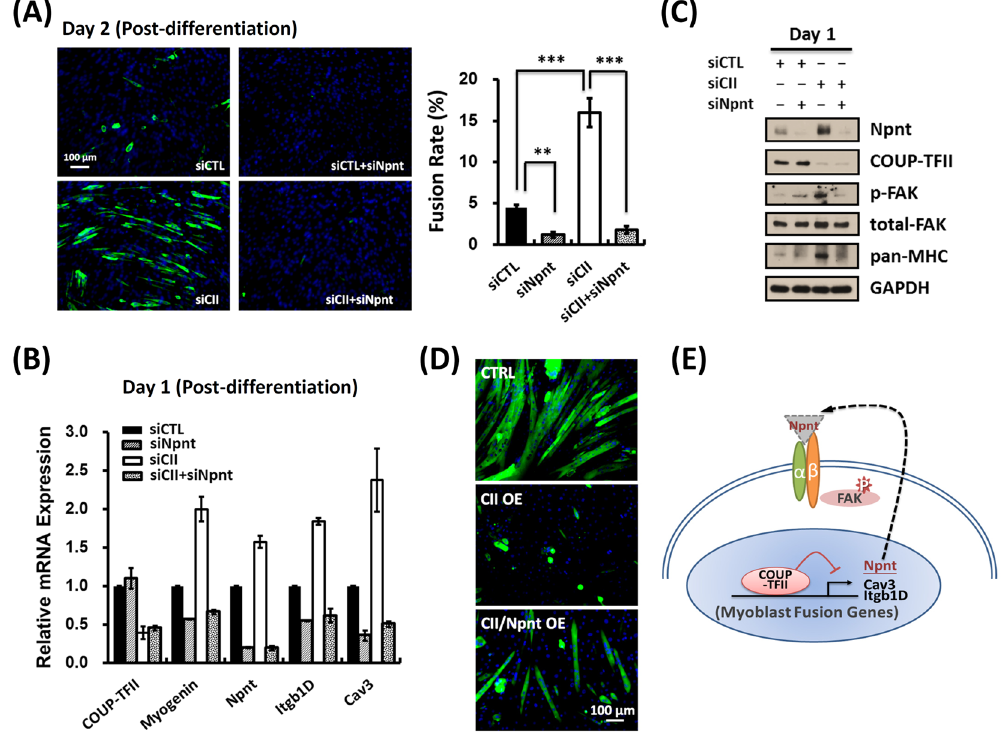
Figure 6. Npnt is essential for COUP-TFII silencing mediated acceleration of myogenesis. ( A ) Two days post- differentiation, indicated cells were fixed and immunostained with pan-MHC (left panel), and their fusion rates were then quantified as the percentage of MyHC + nuclei versus total nuclei (right panel). ( B ) Quantitative RT- PCR examination of indicated genes expression; ( C ) Immunoblotting of indicated protein expression in control, COUP-TFII silencing, Npnt silencing and double silencing C2C12 cells, one day post-differentiation. Cells were pre-silencing of indicated genes 3 days and reseeded before serum withdrawal. ( D ) COUP-TFII overexpressed cells were infected with control or Npnt overexpressed lentiviruses for three days and the serum was withdrawn for differentiation. Six days post-differentiation, indicated cells were fixed and immunostained with pan-MHC antibodies. ( E ) Illustration of the molecular mechanisms of COUP-TFII-mediated inhibition of myoblast fusion. Data are shown as mean ± SEM. Two-tailed Student’s t test; ** p < 0.01, *** p <